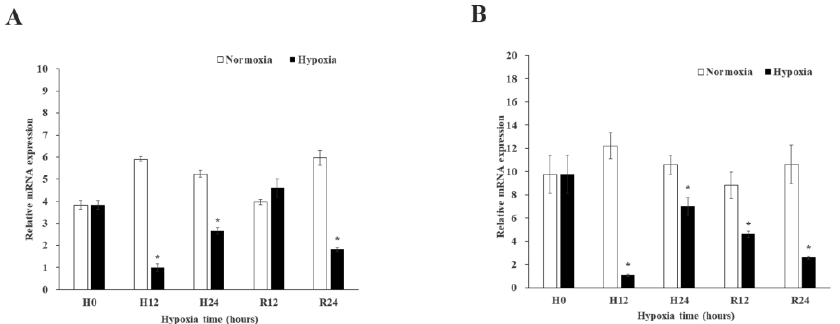
Figure 3. Expression of MnGST-1 ( A ) and MnGST-2 ( B ) in the hepatopancreas of M. nipponense at five time points after hypoxia and reoxygenation (H0: hypoxia for 0 h; H12: hypoxia for 12 h; H24: hypoxia for 24 h; R12: reoxygenation for 12 h; R24: reoxygenation for 24 h). Data indicated with asterisks are significantly different ( p < 0.05) between treatment and control groups. Values are means ± SE for triplicate samples.